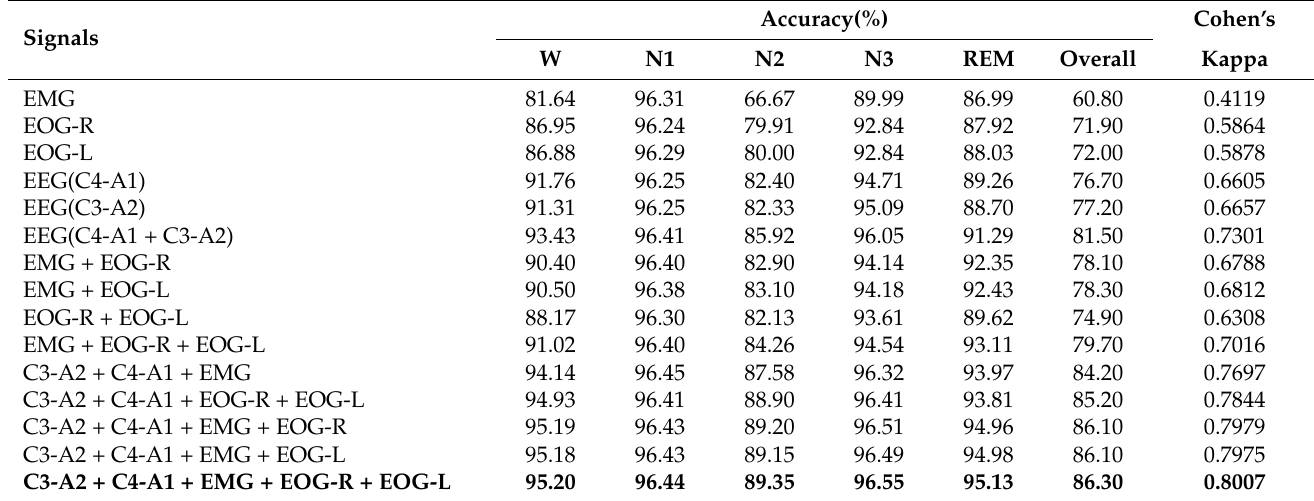
Table 5. Classification performance using different combinations of channels for classifying five sleep stages using SHHS-2.